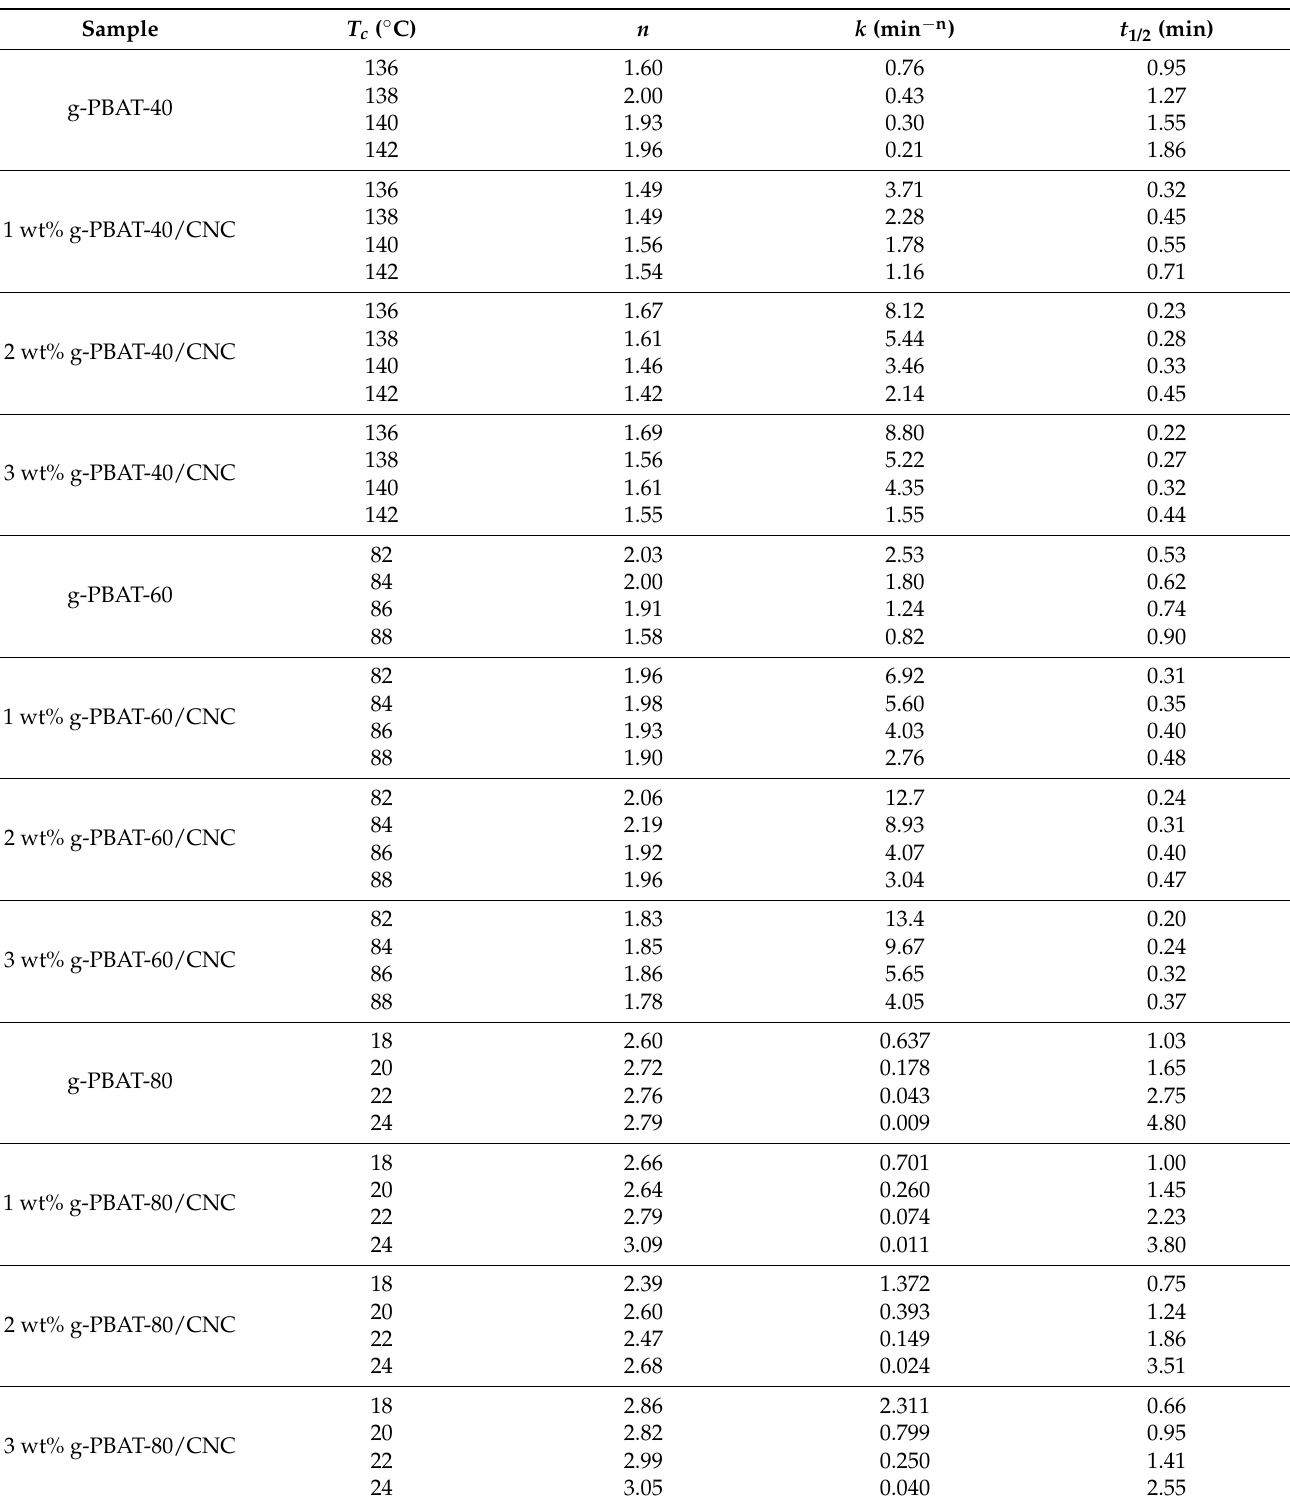
Table 3. Kinetic parameters of g-PBAT/CNC nanocomposites isothermally melt-crystallized at various T cs